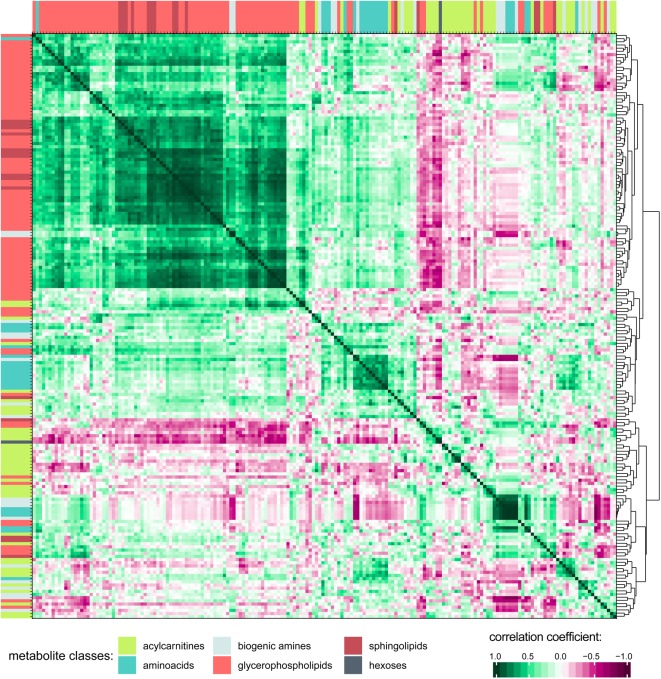
Correlation matrix of all metabolites in PD effluent after a 4 h peritoneal equilibration test (PET) dwell. Pearson’s correlation coefficients were calculated for all metabolite combinations. Only detectable (non-zero) metabolites are included in the correlation matrix. Hierarchical clustering was performed on the Euclidian distance between the metabolites’ correlation coefficients. Metabolites are colored by substance class (Supplementary Figure S2 shows this figure at higher resolution, and includes metabolite names).